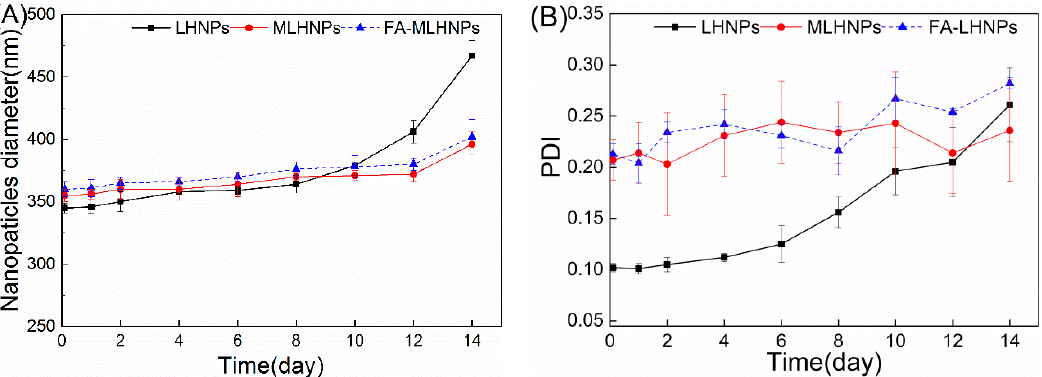
Figure 4. Stability of LHNPs after 14 day incubation in PBS (pH 7.4) at 37 °C, effects on the average diameter ( A ), PDI ( B ).